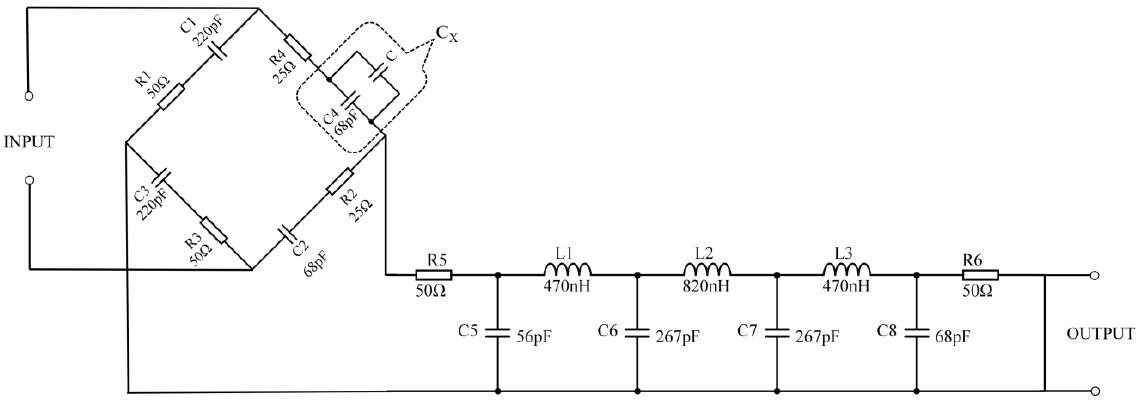
Figure 2. The sensor signal conditioning circuit.